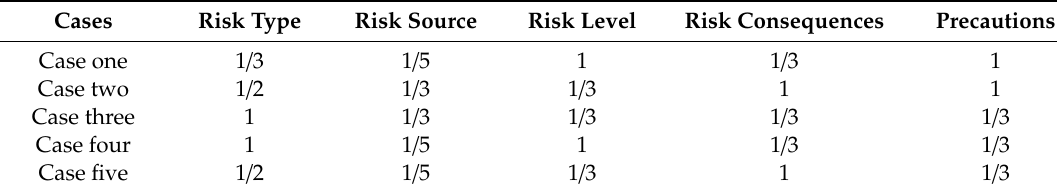
Table 10. Semantic correlation calculation